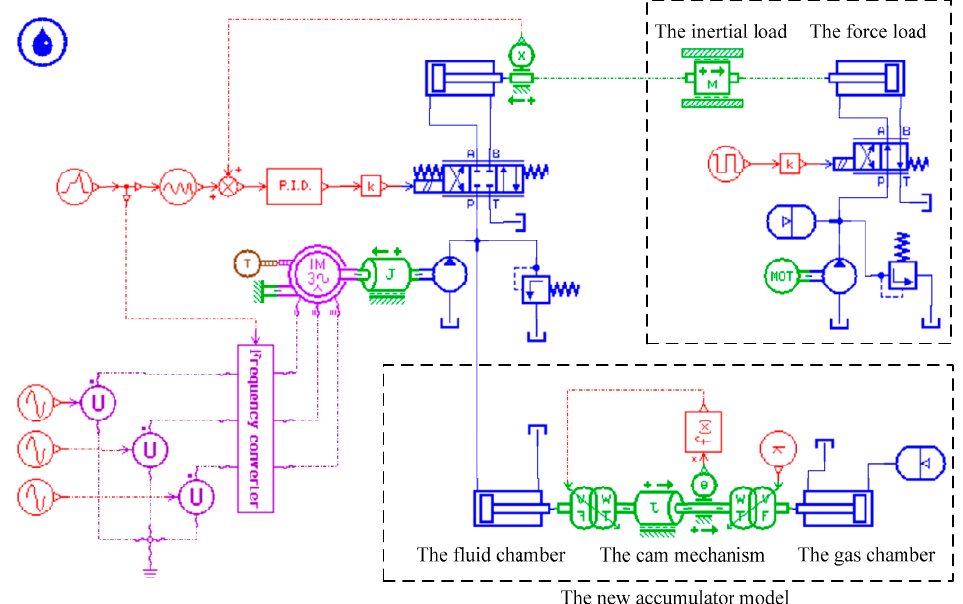
Figure 6. Simulation model constructed on Amesim.